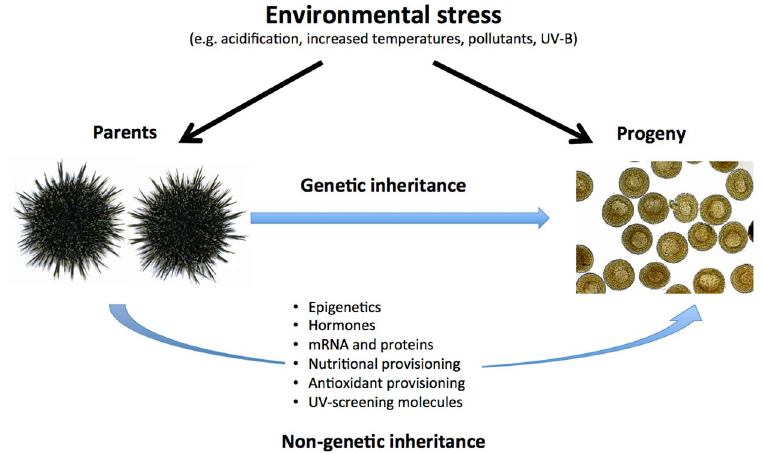
Figure 1. Parents can influence the ability of their progeny to respond to environmental stress through genetic and non-genetic pathways. Modified from ref.